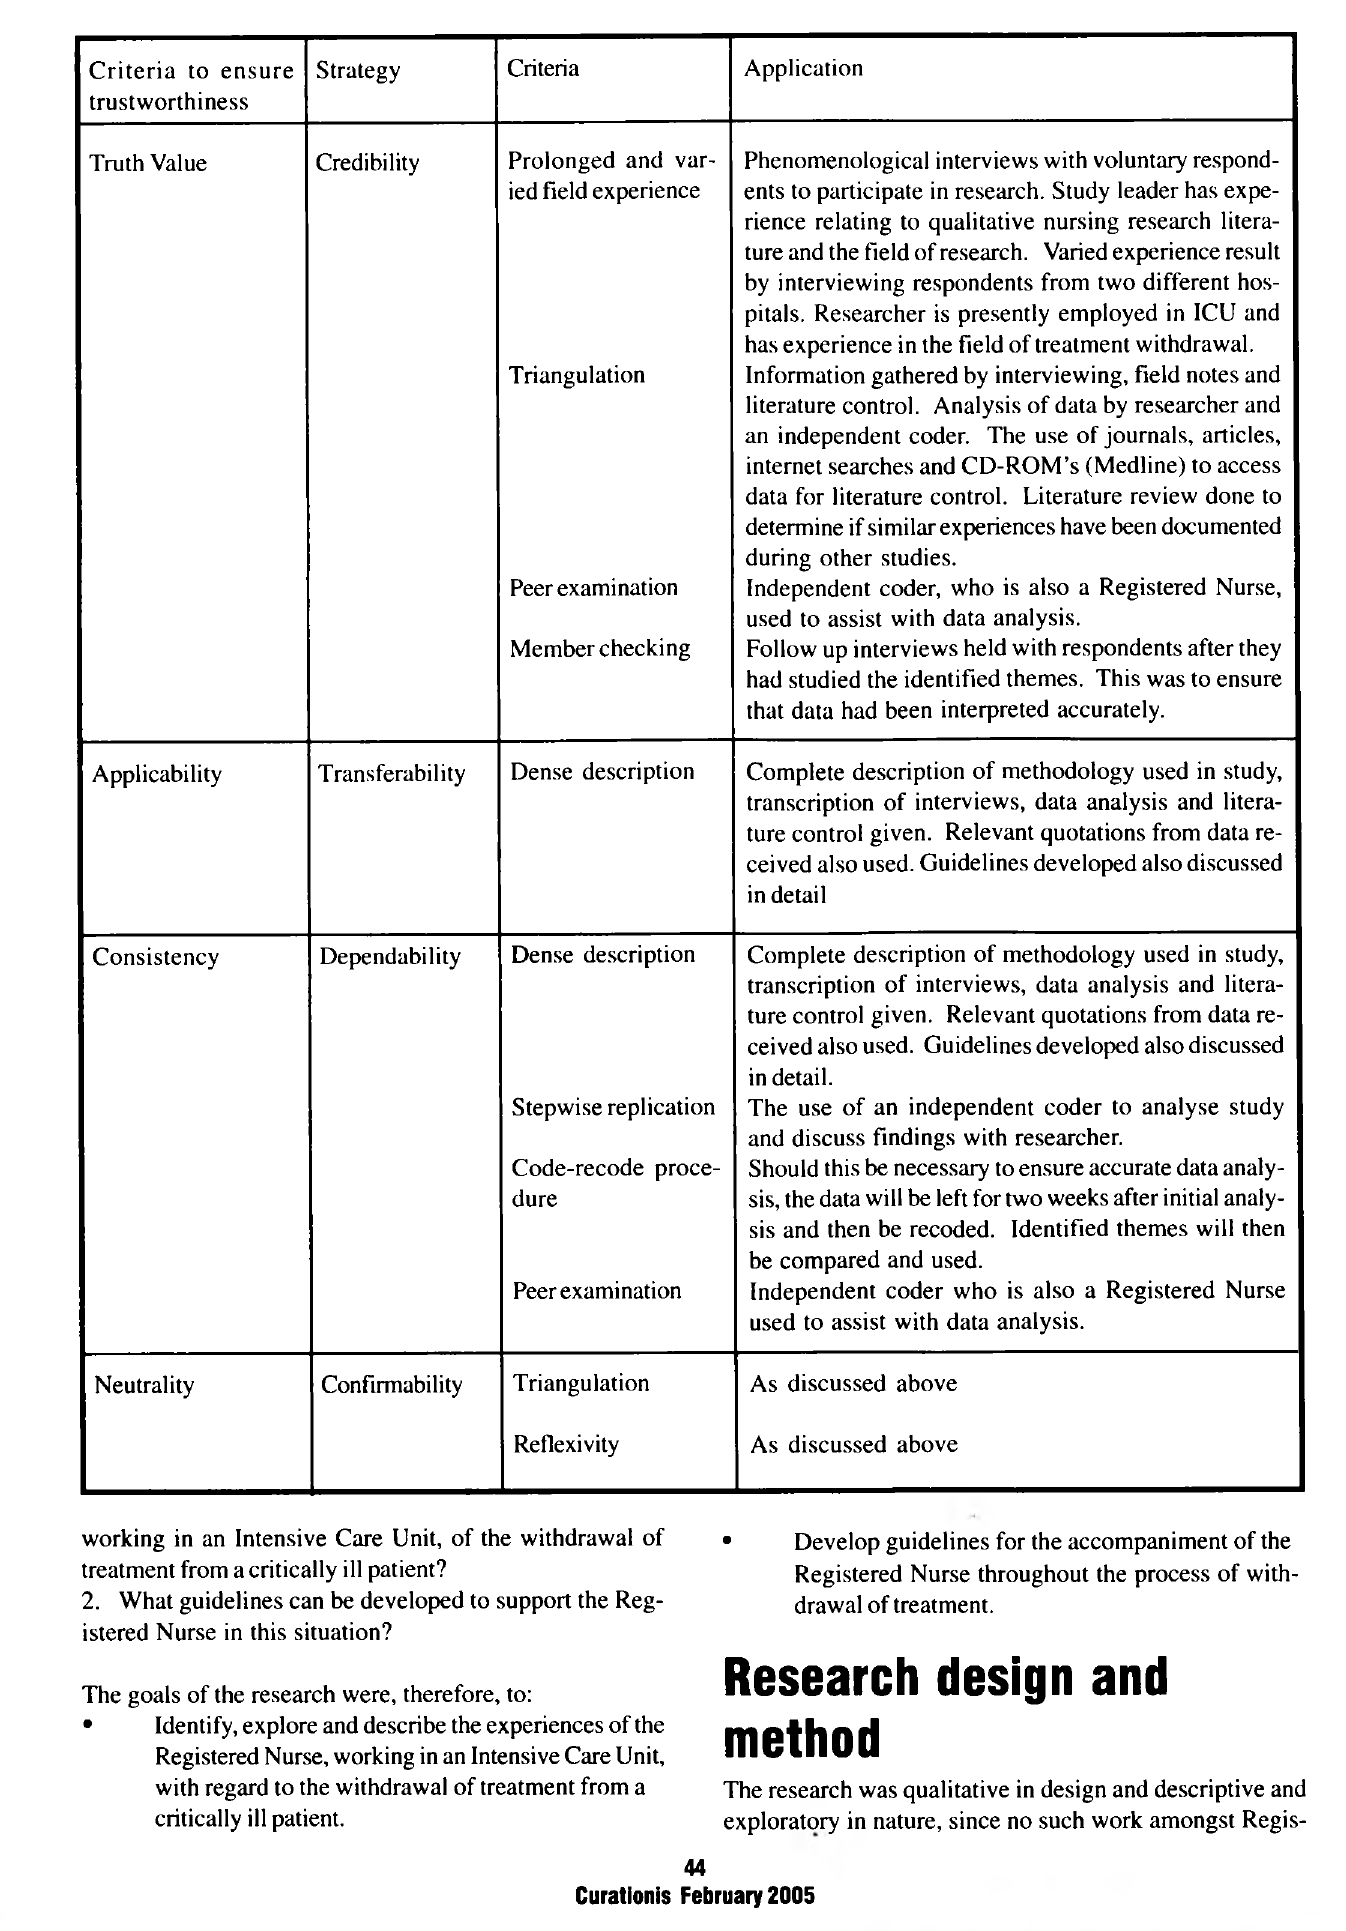
Table 1 : A summary of the strategies implemented in order to ensure trustworthiness